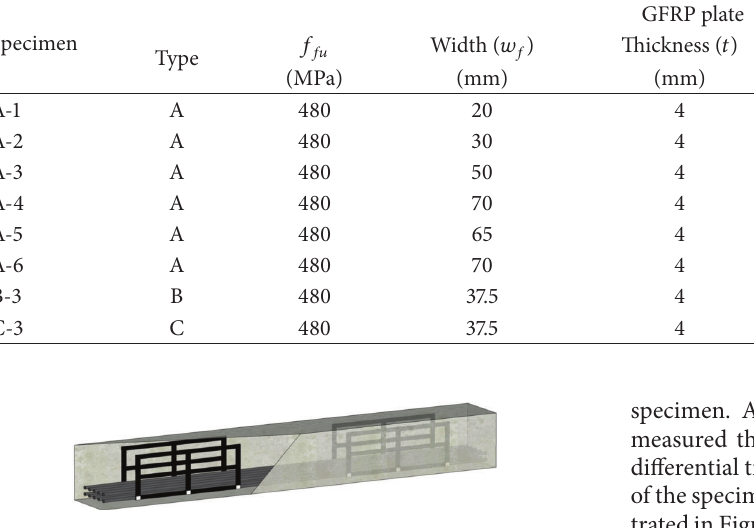
Figure 1: Schematic view of a concrete beam reinforced with GFRP